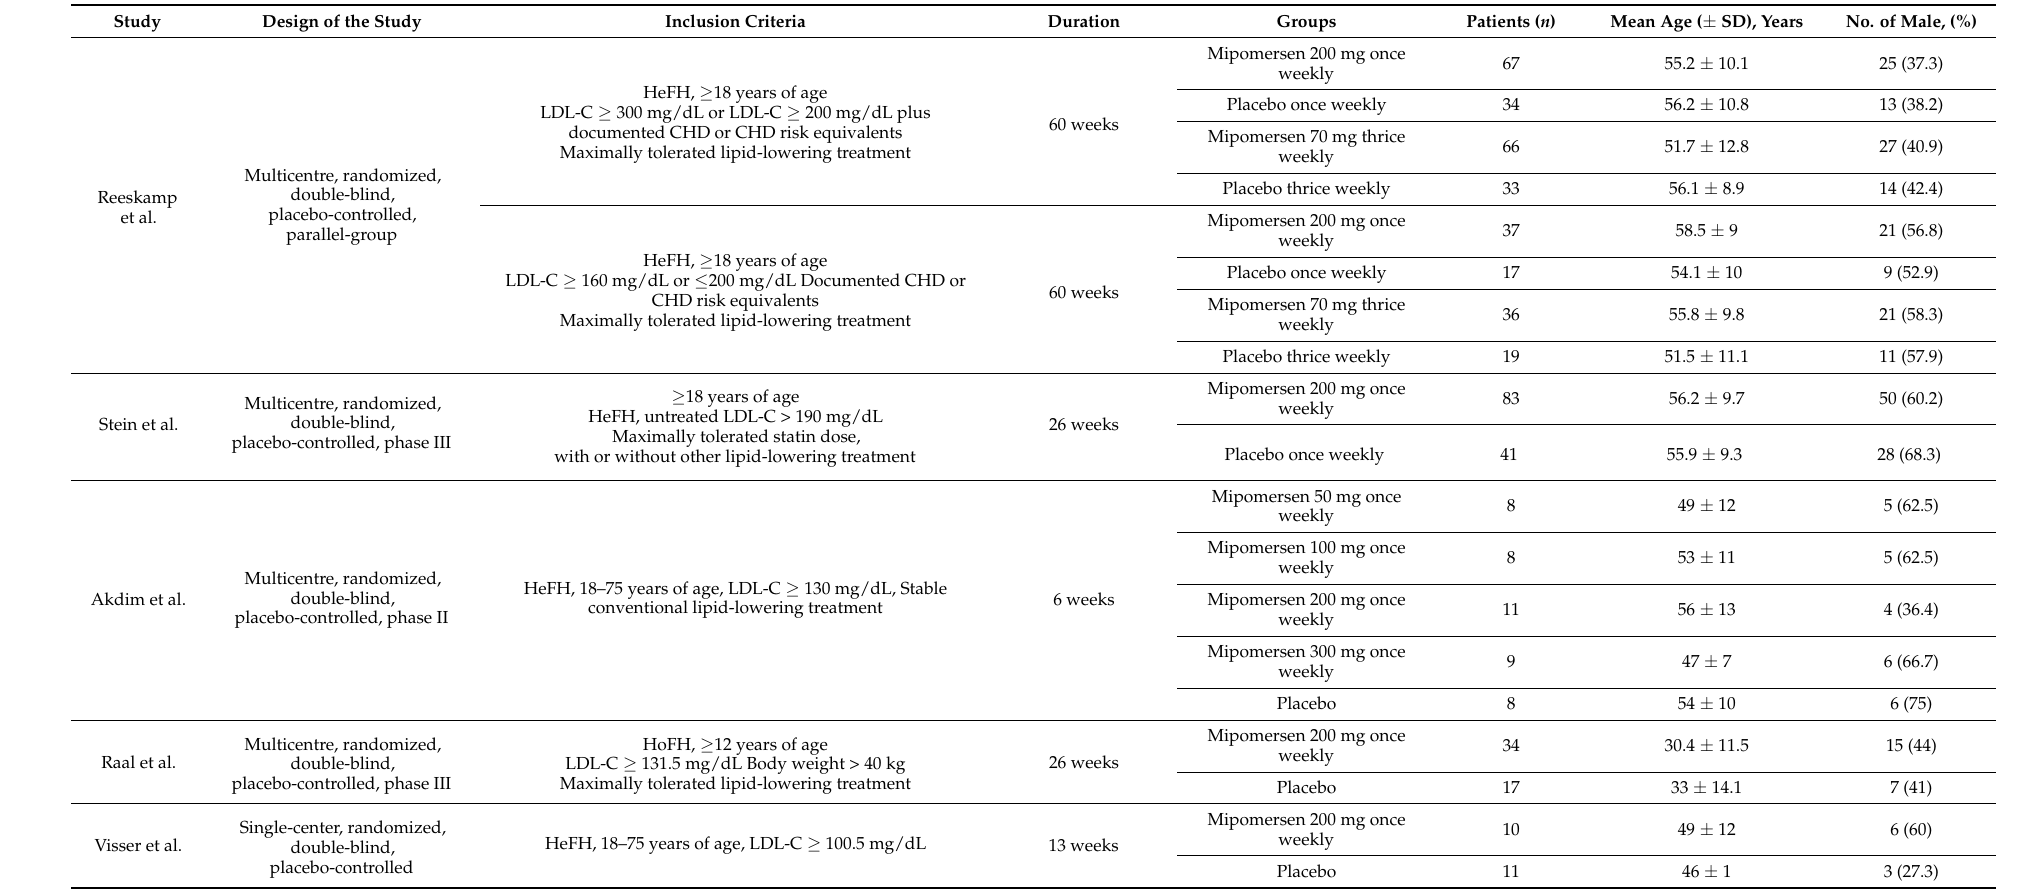
Table 1. Baseline characteristics of the included